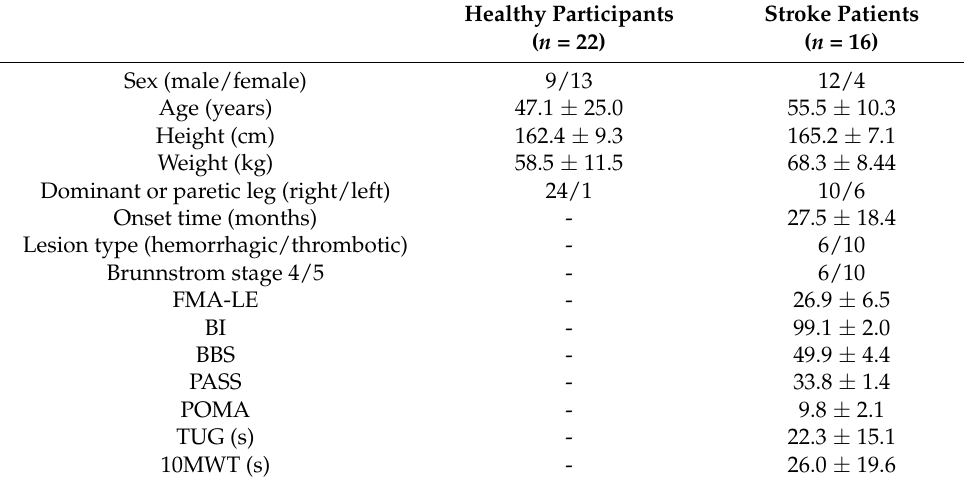
Table 1. Participant characteristics.